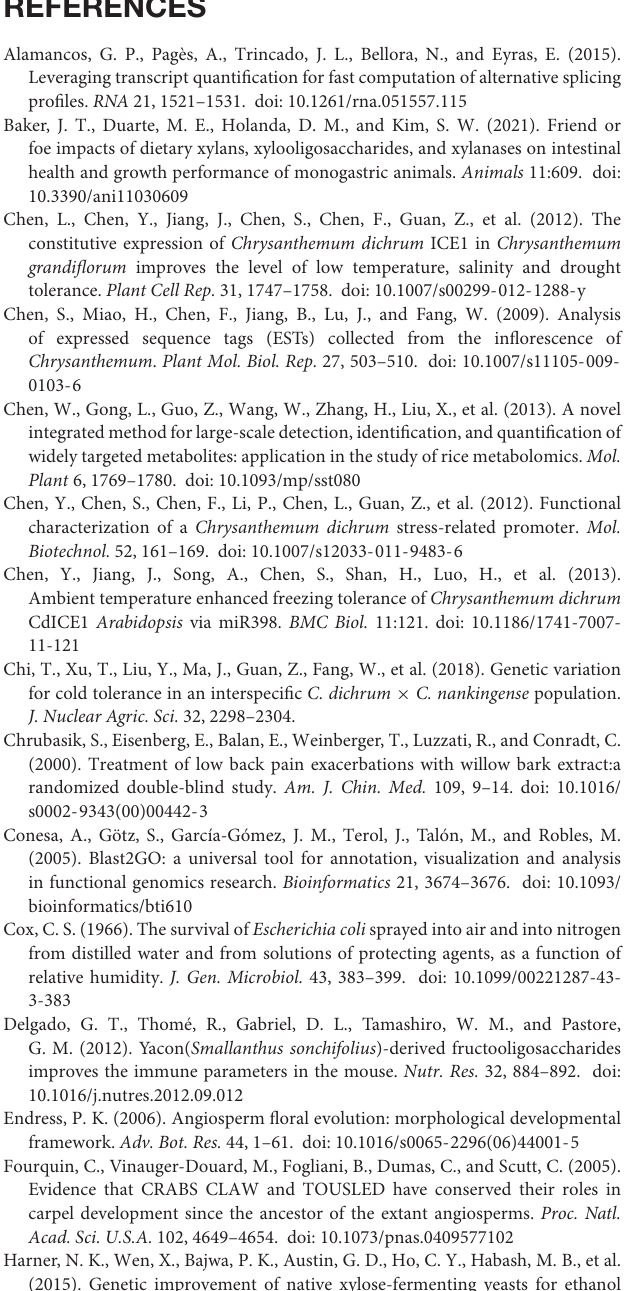
Supplementary Table 8 | GO functional categorization of significantly up-regulated and down-regulated differentially expressed genes between Chrysanthemum dichrum flower buds and blooming flowers. Supplementary Table 9 | Enriched KEGG pathways among the significantly up-regulated differentially expressed genes between Chrysanthemum dichrum leaves and blooming flowers. Supplementary Table 10 | Details regarding the 15 primers used for the quantitative real-time PCR analysis of Chrysanthemum dichrum genes.